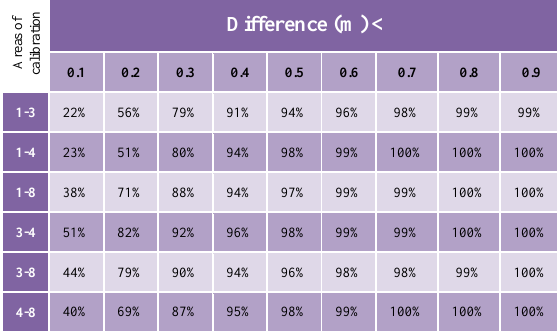
Table 4: Percentiles of the differences between the remaining calibration areas of image 5419 which are lower than the thresholds indicated by the column headers